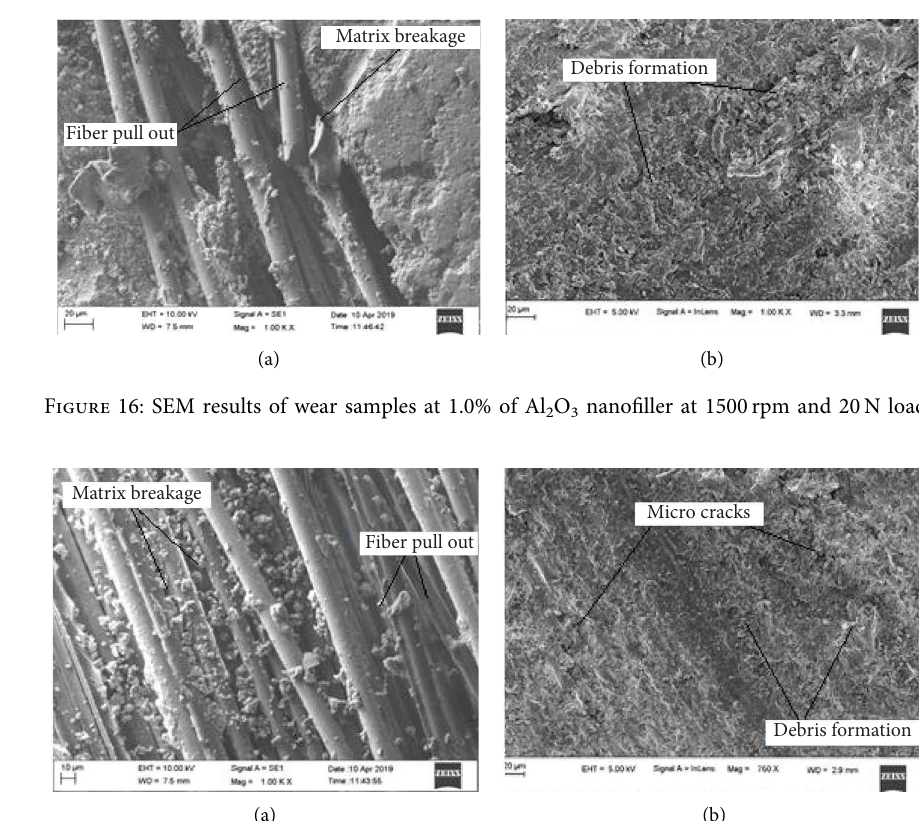
2 O 3 nanofller at 1500rpm and 60N